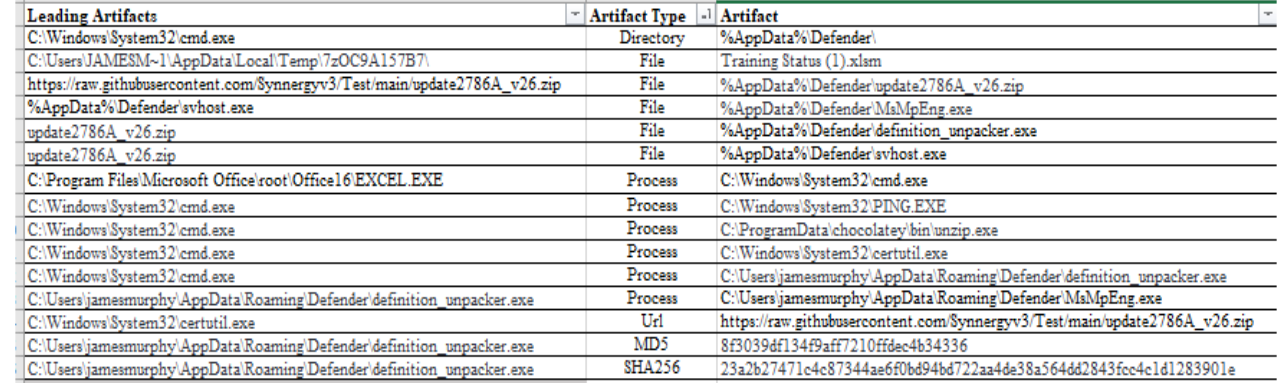
Figure 19. Hunt artifacts uncovered.